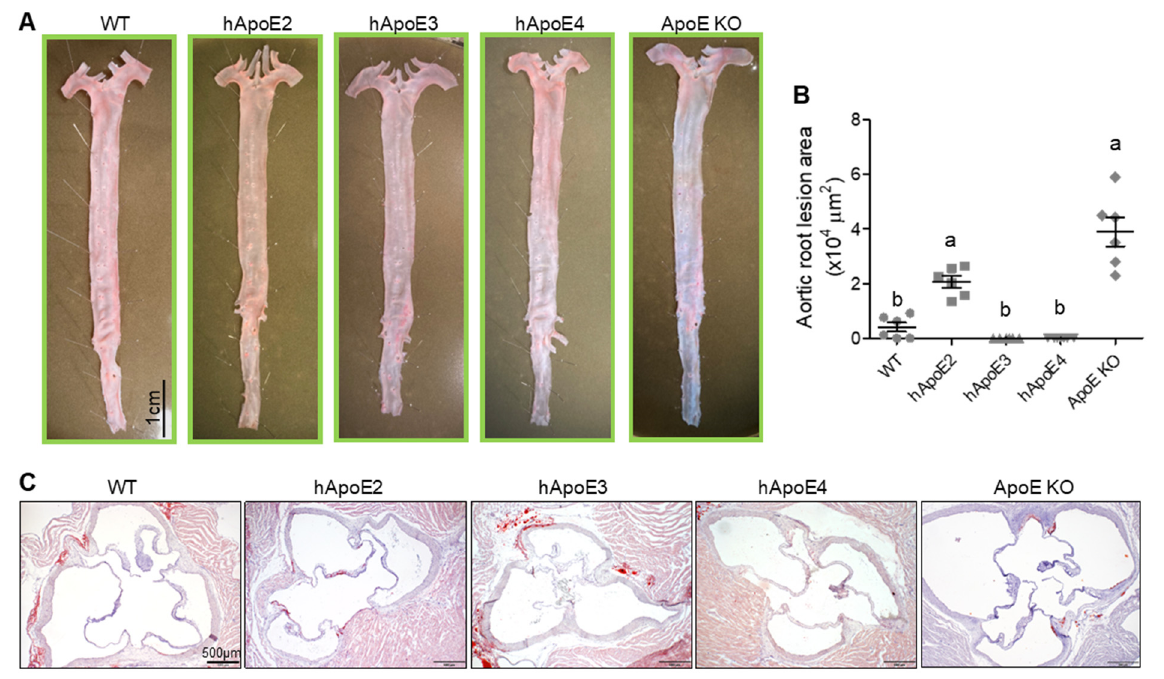
Figure 5. Mild atherosclerotic plaque formation in hApoE2 and ApoE KO rats. ( A ) Representative photographs of Oil Red O-stained en face aortas from rats aged 6 months are shown. ( B ) Plaque lesion areas in cross-sectional aortic roots of different rats were quantified at age 6 months. (n = 6 per group, One-way ANOVA followed by a Tukey post hoc test. a vs. b, significant difference p < 0.05). ( C ) Representative photomicrographs of Oil Red O-stained cross-sectional aortic roots are shown.